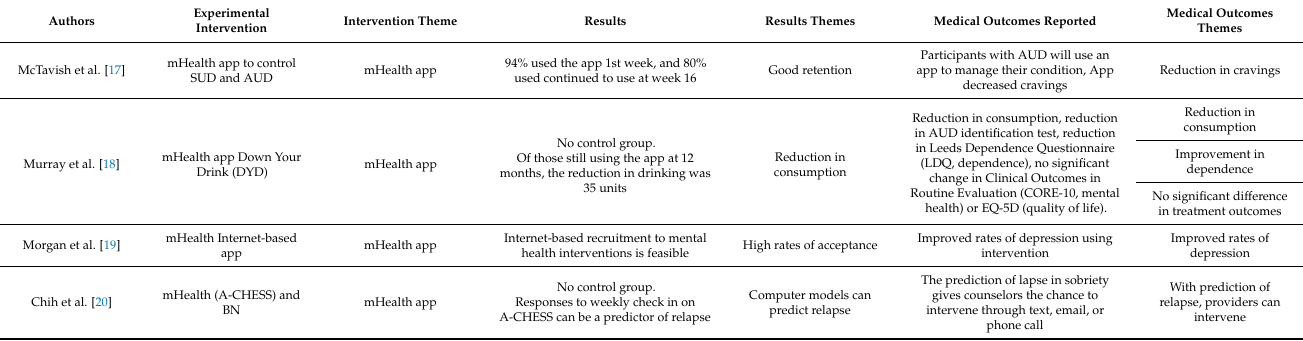
Table A1. Observation-to-theme conversion (Intervention, Results, Medical